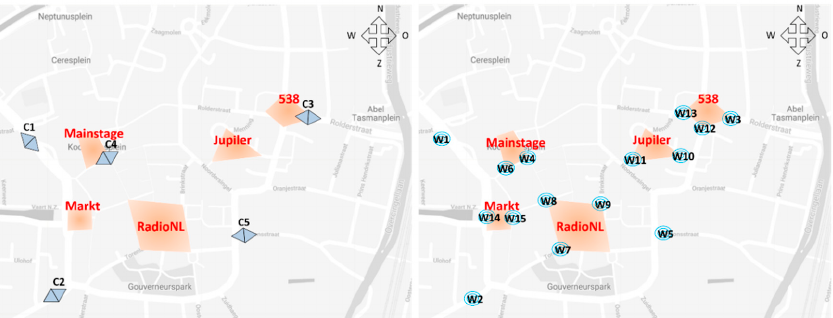
Figure 2. The layout of the sensor network depicted on a map for the TT Festival terrain of 2018, where the circles with the W-code represent the Wi-Fi sensors and the double triangles with the C-code represent the automated counting systems.